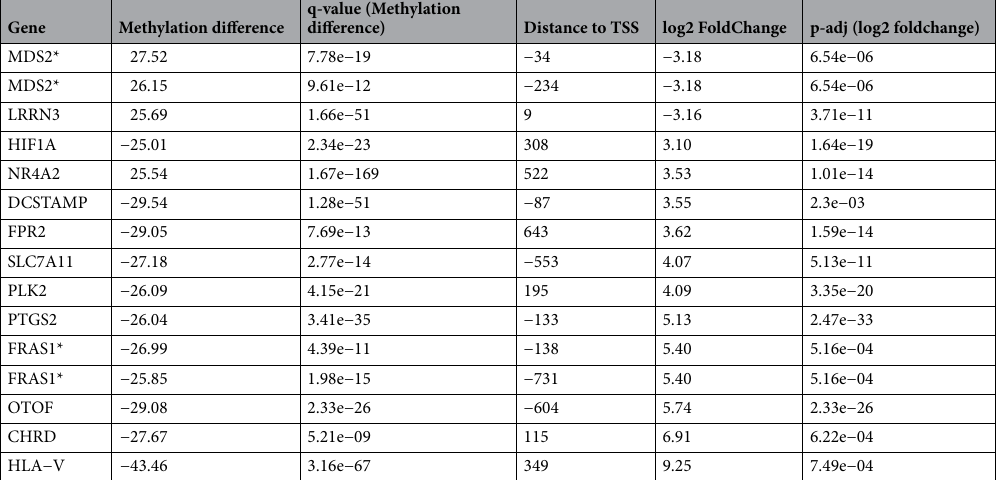
Table 2. Subset of genes with DNA methylation and gene expression association in subjects failing cART compared to control group. CT Control group, VF Virologic failure group, TSS Transcription Start Site. *Differentially expressed genes associated with two differentially methylated regions.